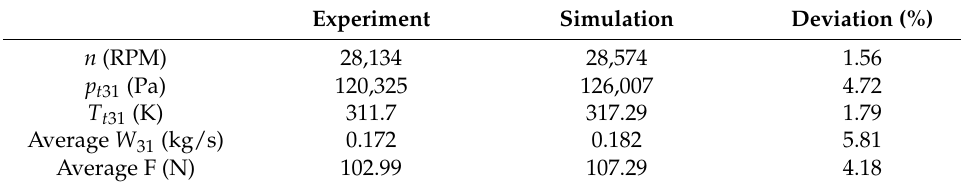
Table 4. Experiment and simulation results of PDTE at f = 20